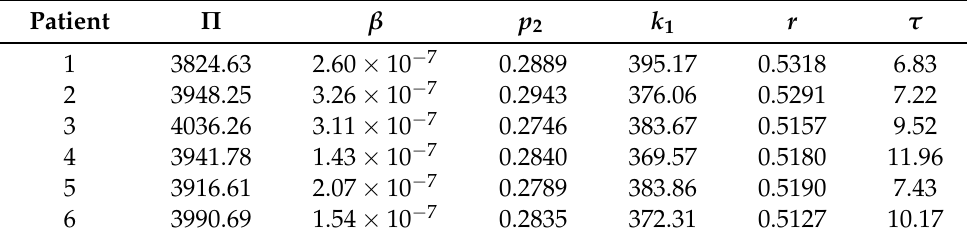
Table 3. Selected parameters and their converged values estimated by the